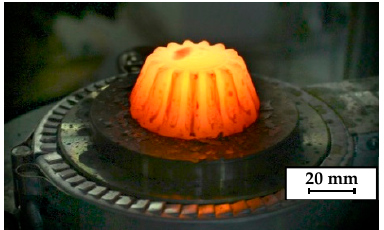
Figure 4. A bevel gear after the forging process.